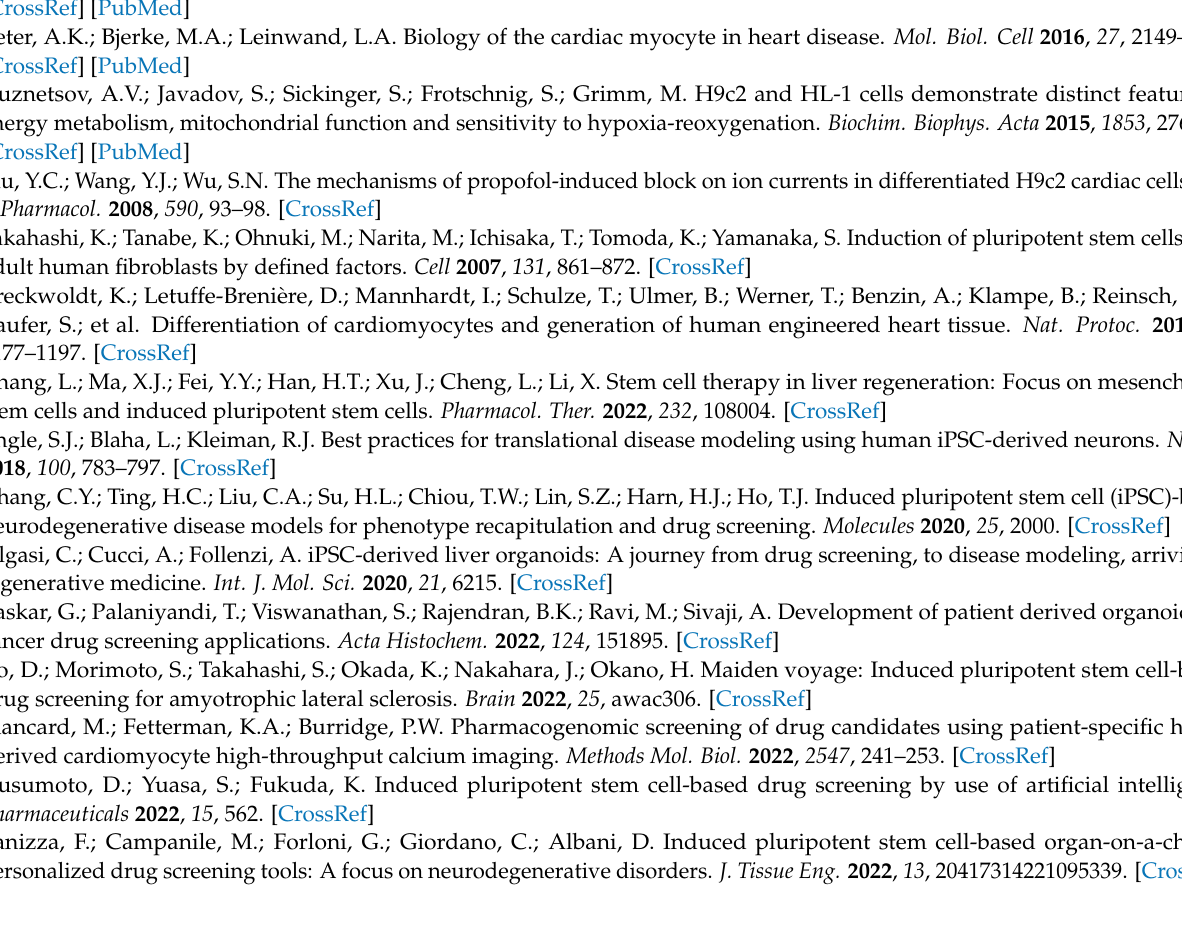
Figure S2: Contractile dysfunction in doxorubicin-treated hiPSC − differentiated cardiomyocytes (hiPSC − CMs); Figure S3: Quantification of reactive oxygen species (ROS) generated in doxorubicin- treated human induced pluripotent stem cell-derived cardiomyocytes; Video S1: Sorafenib treatment caused a decrease in hiPSC-CM